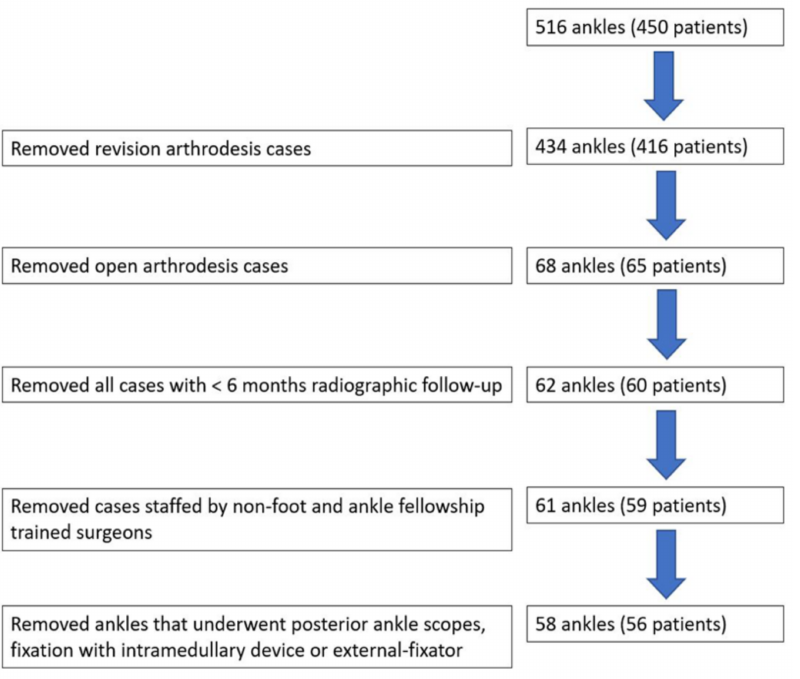
Figure 1. The data exclusion flow chart for the present study.